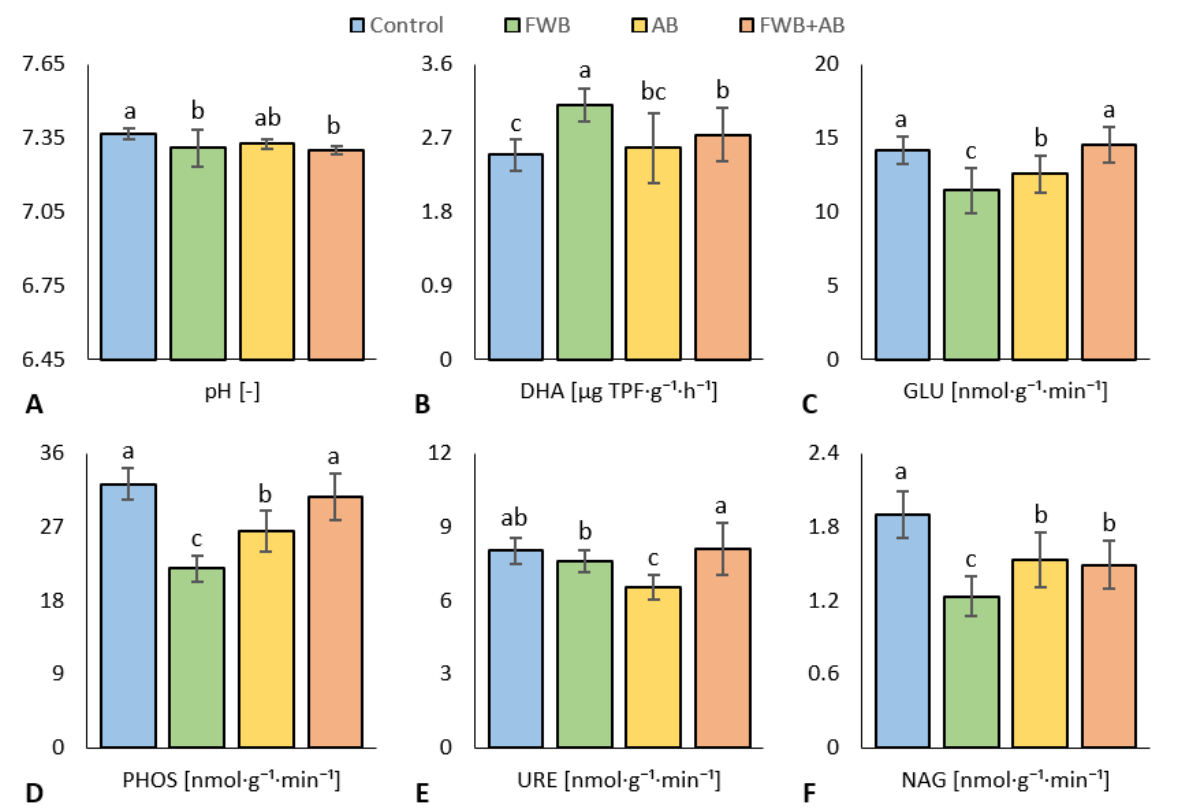
Figure 3. The responses of soil pH ( A ) and extracellular enzyme activities ( B – F ) under the applied amendments. Different lowercase letters indicate statistically significant differences within columns. n = 3.